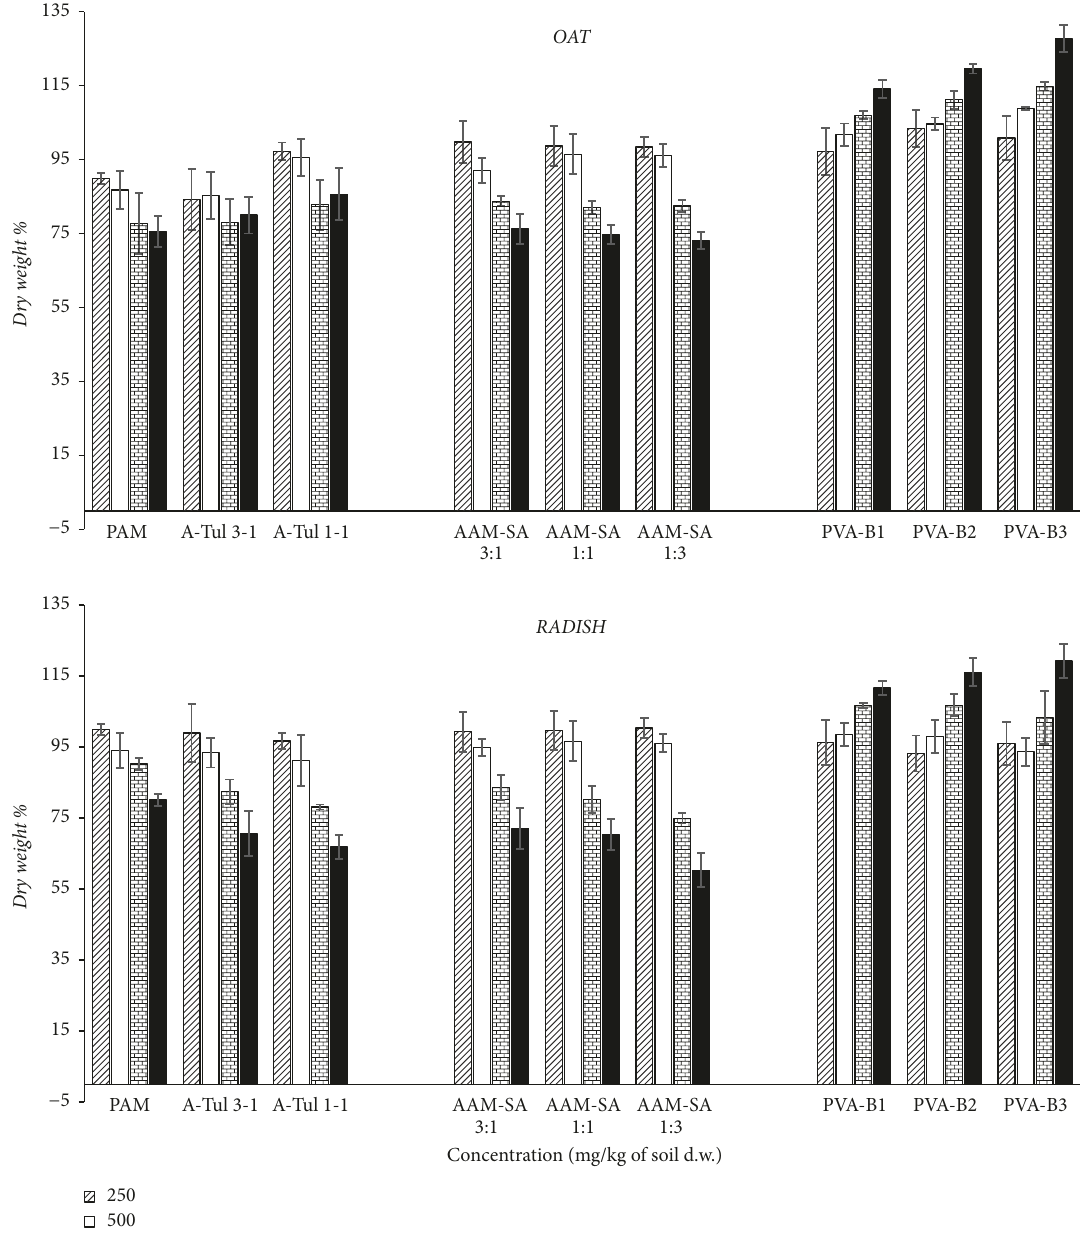
Figure 3: Changes in dry weight of treated plants expressed as percent value of untreated